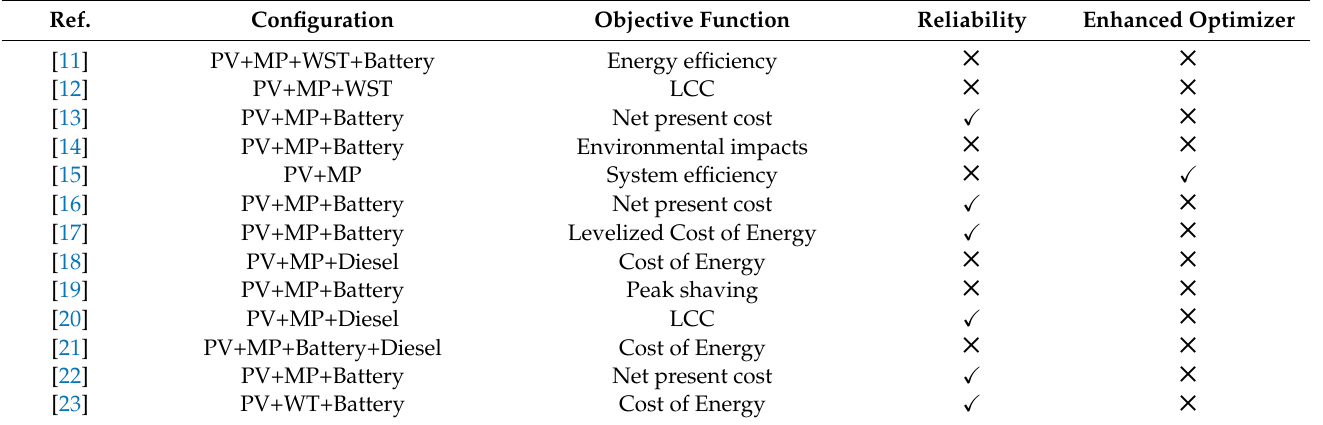
Table 1. Summary of literature review.